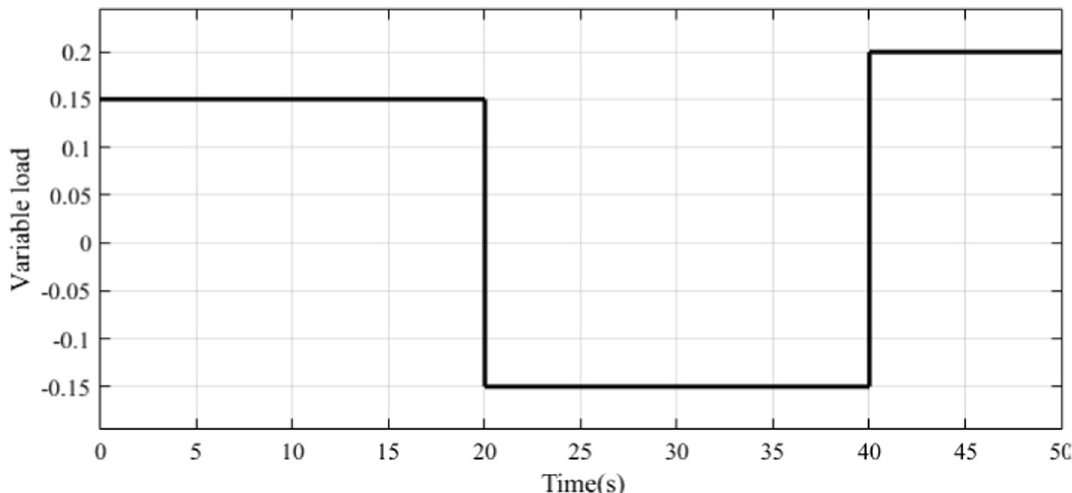
Fig. 12 Variable step load pattern